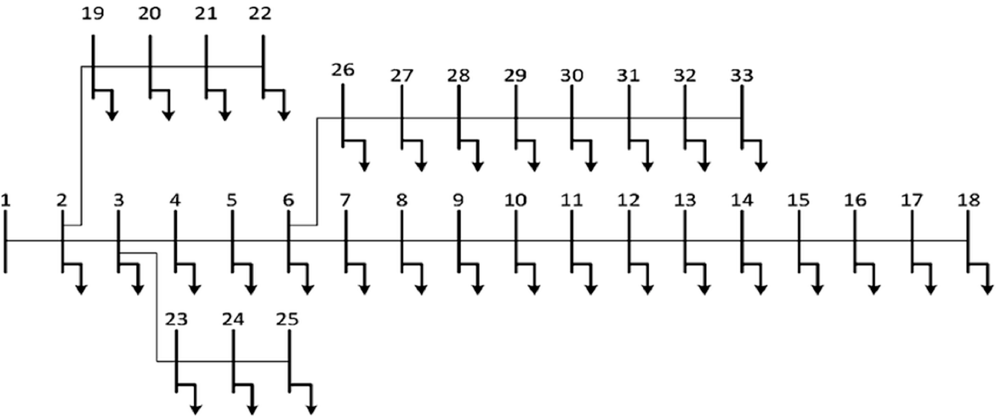
Figure 3. The diagram of the IEEE 33-bus radial distribution system. Table 1. The data of the IEEE 33-bus distribution network [37].